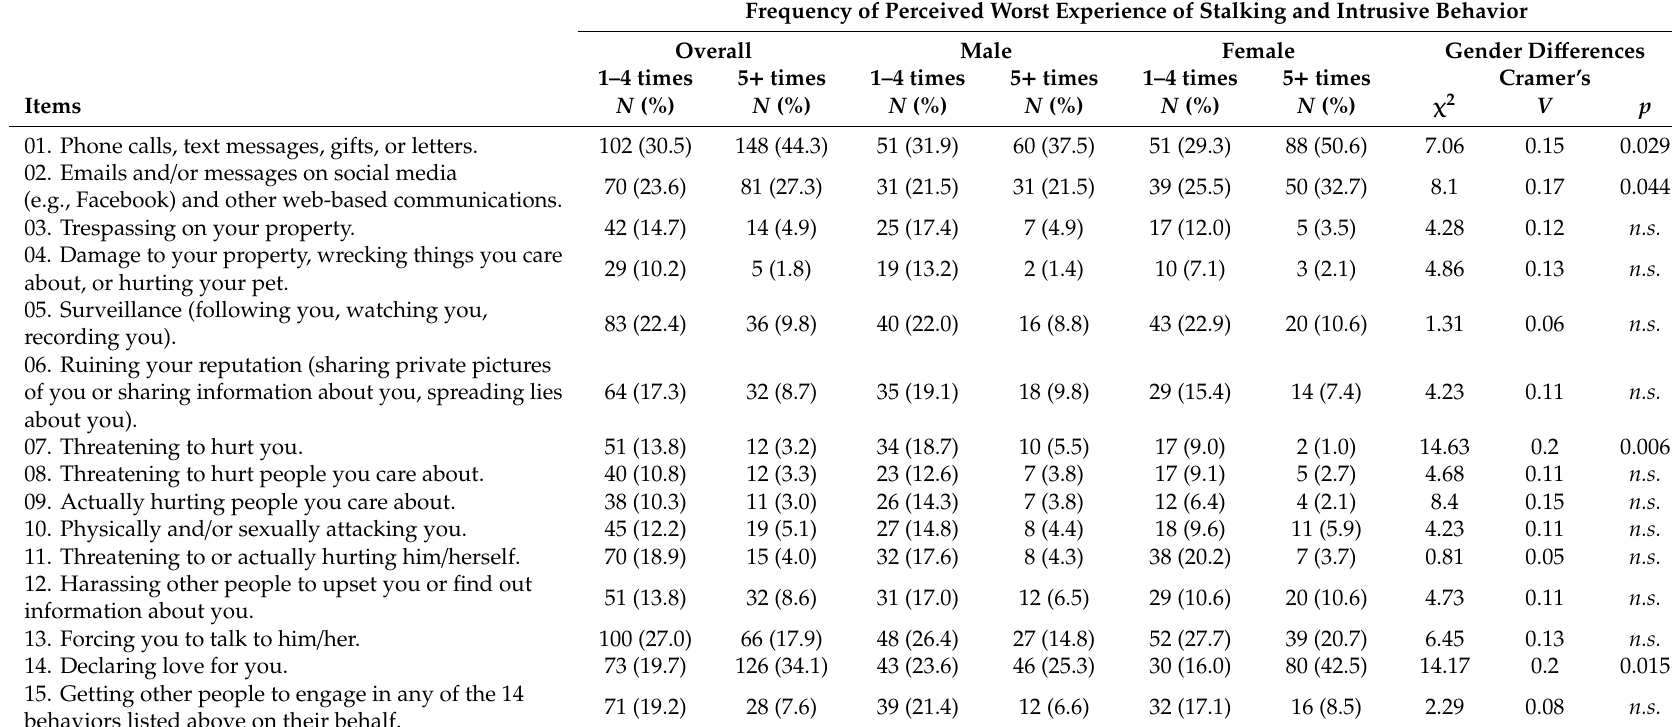
Table 3. Gender di ff erences on frequency of perceived worst experience of stalking and intrusive behavior ( N = 371). Frequency of Perceived Worst Experience of Stalking and Intrusive Behavior Overall Male Female Gender Di ff erences 1–4 times 5 + times 1–4 times 5 + times 1–4 times 5 + times